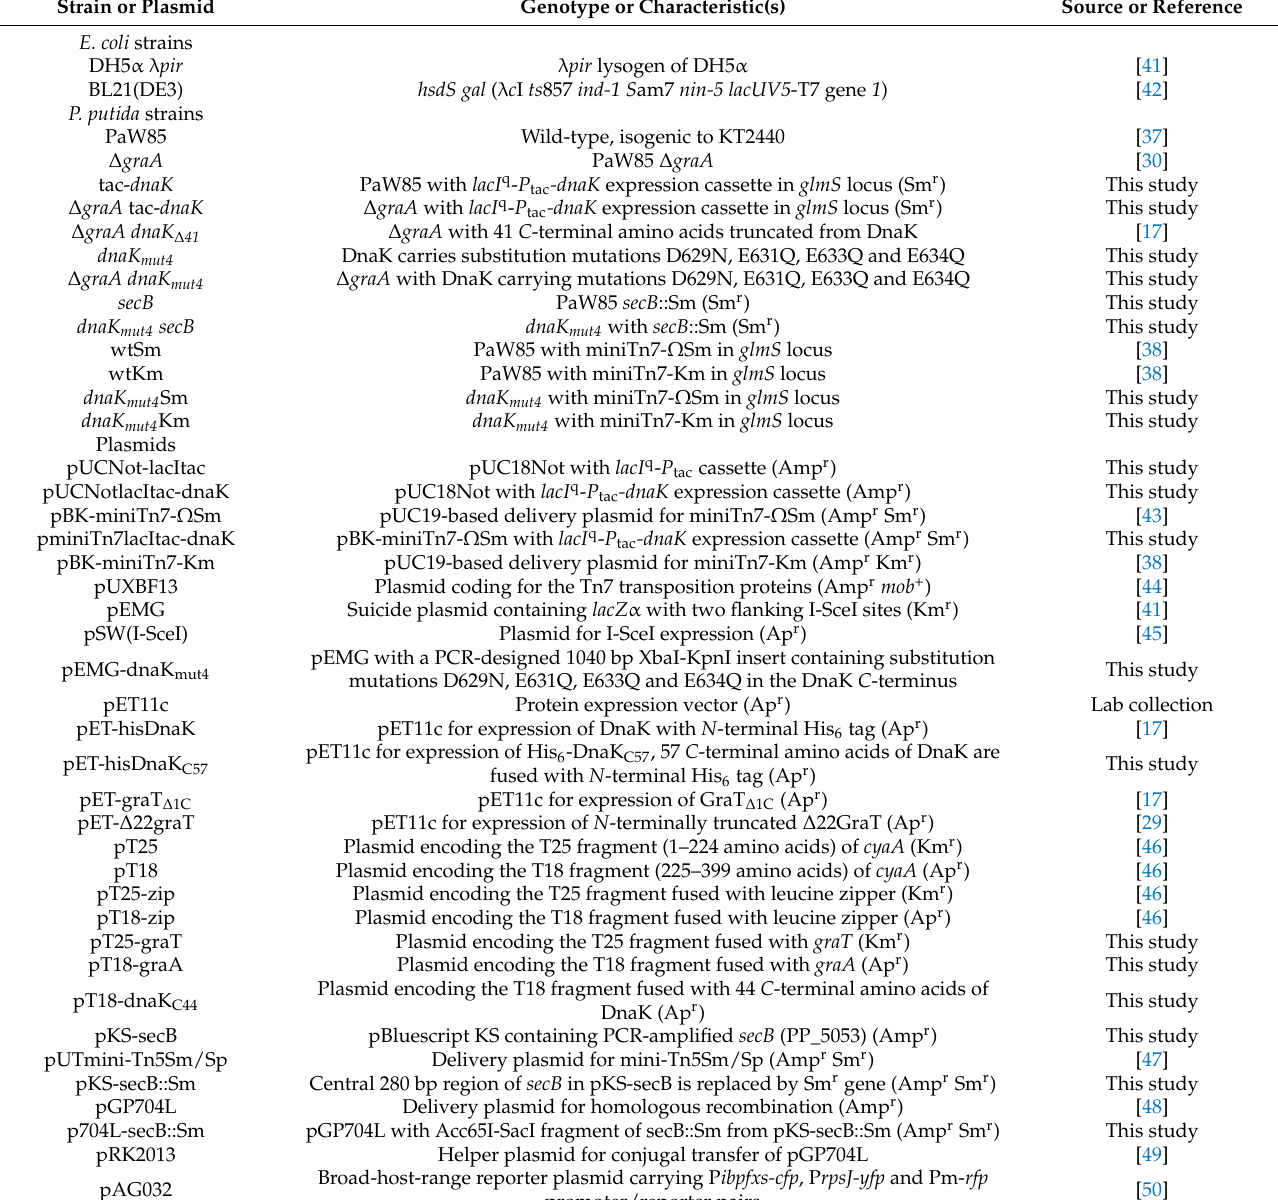
Table 1. Bacterial strains and